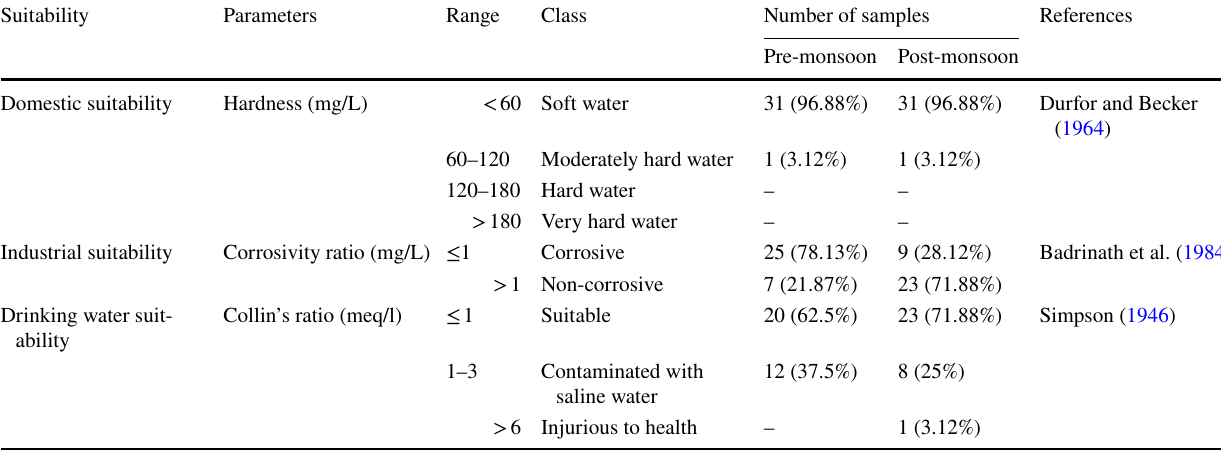
Table 7 Water suitability for different purposes using different parameters